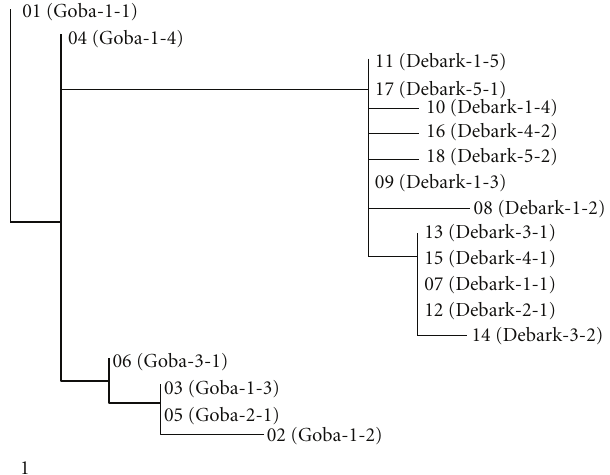
Figure 1: Minimum spanning tree (MST) of the 18 haplotypes generated from the ten L. rhynchopetalum populations. The MST was based on the K2p distance method. Numbers 01–18 are the haplotypes whereas the text in parenthesis is the population from which the haplotypes were generated. Note: haplotypes 03 and 05 are the same but in di ff erent populations; haplotypes 11 and 17 are the same but in di ff erent populations; haplotypes 07, 12, 13, and 15 are the same but in di ff erent